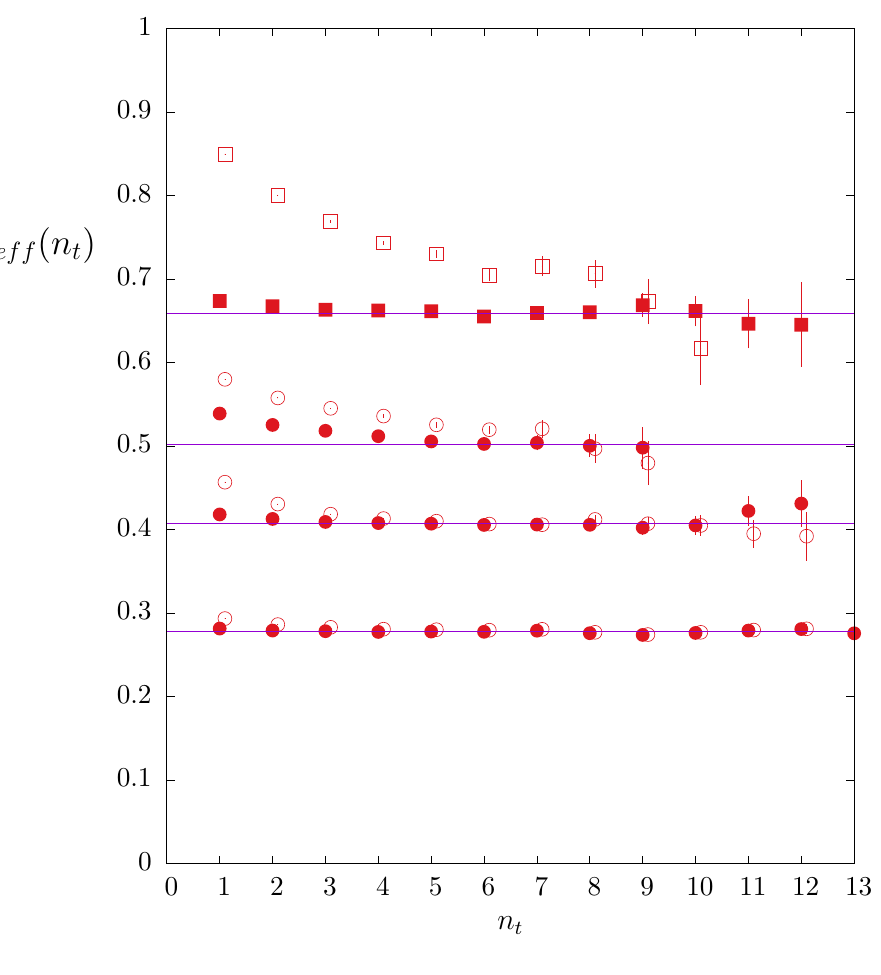
Figure 8 . E(cid:11)ective masses of the lightest three 0 + glueballs ( (cid:15) , (cid:14) ) and the lightest 2 + glueball ( (cid:4) , (cid:3) ) in SU(2) on a 96 2 64 lattice at (cid:12) = 23 : 5. The 2 + values have been shifted by +0 : 2 for clarity. Filled points use operators in the fundamental and open points in the adjoint representations. Lines are mass